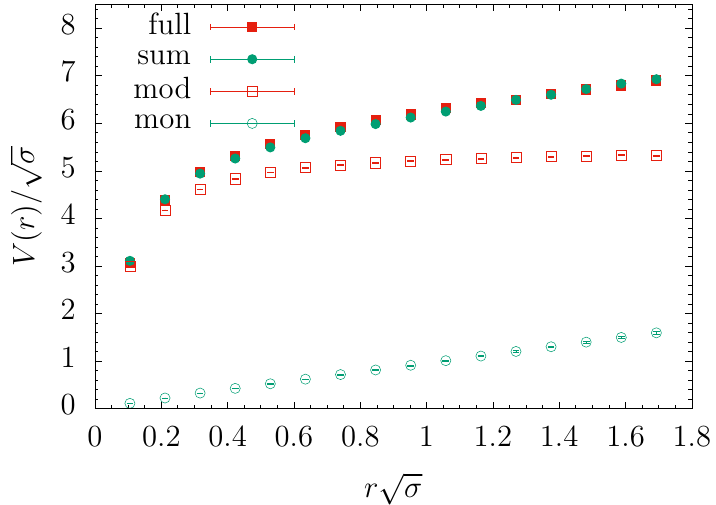
Figure 3. Comparison of the nonabelian static potential V ( r ) (filled symbols) with the sum of the Figure 5. The nonabelian static potential V ( r ) (filled squares) is compared with the sum of the monopole monopole and modified potentials V sum ( r ) (empty symbols) for improved action at β = 3 . 4. and modified potentials V sum ( r ) (filled circles) for QC 2 D at nonzero chemical potential a µ q = 0 . 19. The potentials V mon ( r ) (empty circles) and V mod ( r ) (empty squares) are also